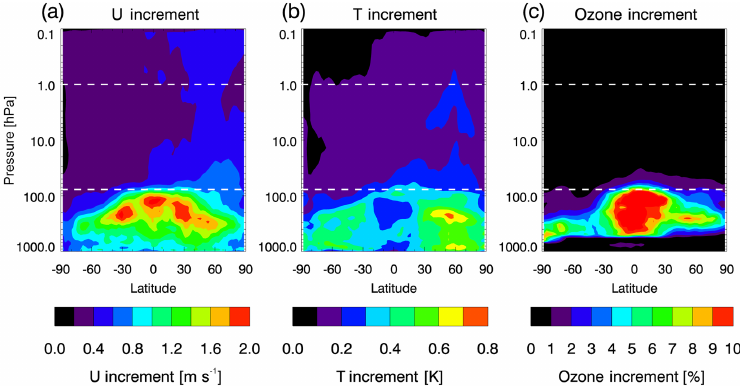
Figure 3. Zonal mean (pressure vs. latitude) plots of (a) the absolute value of the u increment (in ms − 1 ), (b) the absolute value of the T increment (in K), and (c) the absolute value of the ozone increment divided by the analyzed ozone (in %) for the truth experiment, averaged over all cycles from 25 November to 1 December 2014. Red (blue) indicates high (low) values. The region between the white dashed lines indicates vertical range of assimilated stratospheric ozone